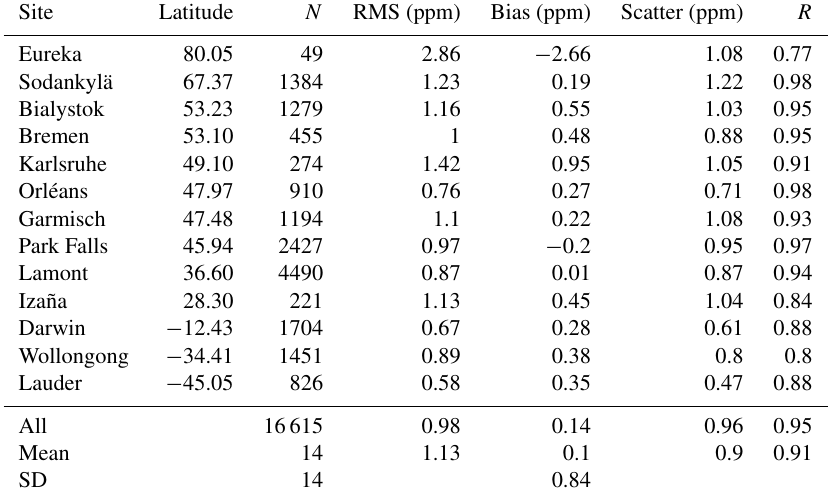
Table 2. Statistics for the average hourly X CO comparison between TCCON measurements and GEM-MACH-GHG simulations: RMS 2 (ppm), bias (ppm), scatter (ppm) and correlation coefficient R . The “all” line shows the mean of each parameter using data from all sites combined. “Mean” is the average of each parameter and SD is the standard deviation of the station’s bias. N is the number of data pairs (or sites for mean and SD) used in the computation of the statistics.